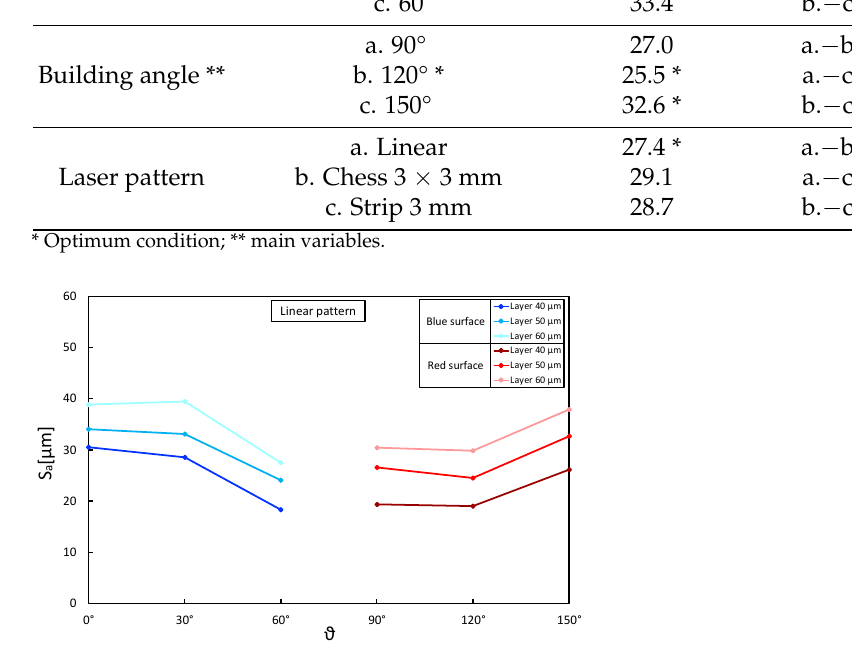
Figure 6. S a as a function of layer thickness ( t ) and building angle ( θ ): linear laser pattern.